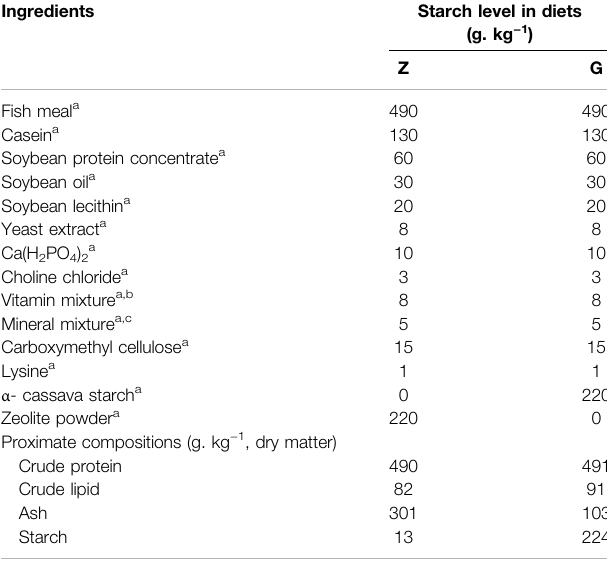
TABLE 1 | Formulation and proximate composition of the experimental diets.